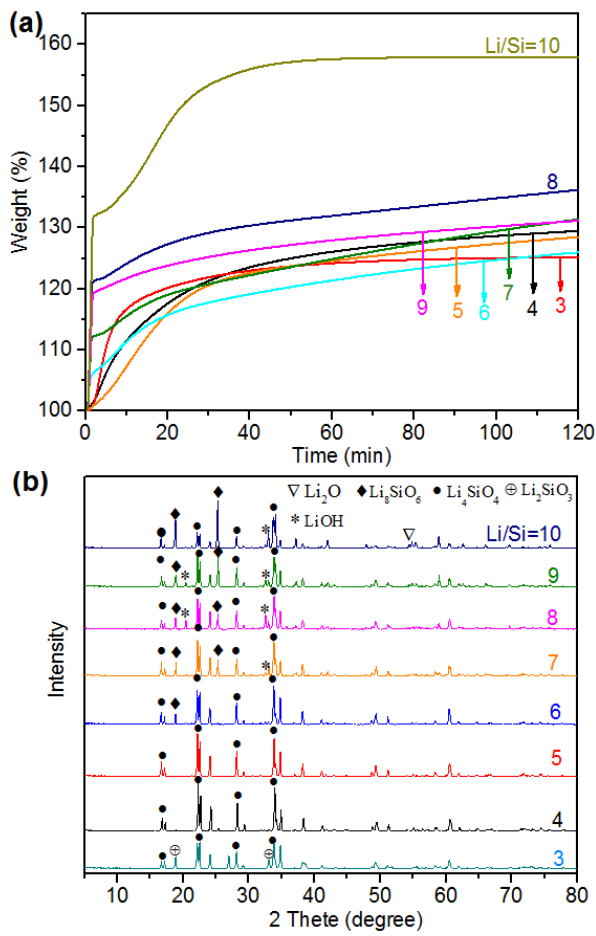
Figure 4. ( a ) CO 2 sorption capacity of Li 4 SiO 4 -(EX-VMT)- x ( x = 3, 4, 5, 6, 7, 8, 9, and 10) samples at 650 °C, ( b ) XRD patterns of Li 4 SiO 4 -(EX-VMT)- x ( x = 3, 4, 5, 6, 7, 8, 9, and 10) samples.